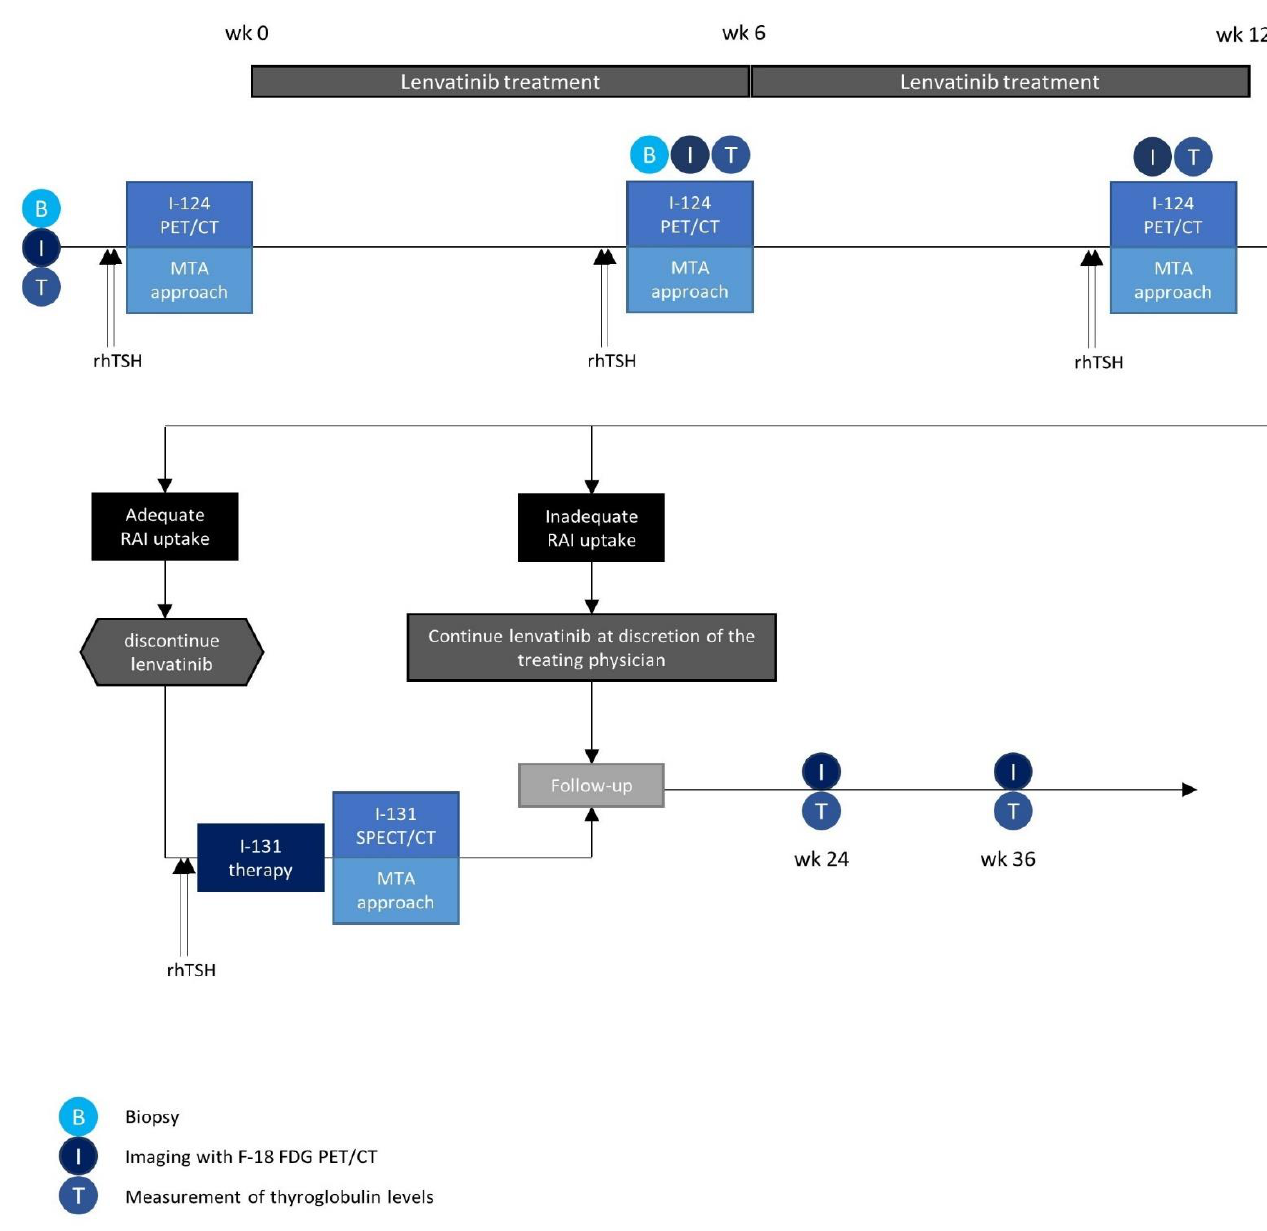
Figure 1. Flowchart of the study for patients in cohort 1, including lenvatinib treatment, dosimetry procedures, I-131 therapy and response evaluation with F-18 FDG PET/CT and serum thyroglobulin levels. Table 1. Overview of all (standard and study) procedures in the RESET trial for cohort 1 and cohort 2 in case of 12 and 6-weeks lenvatinib treatment .